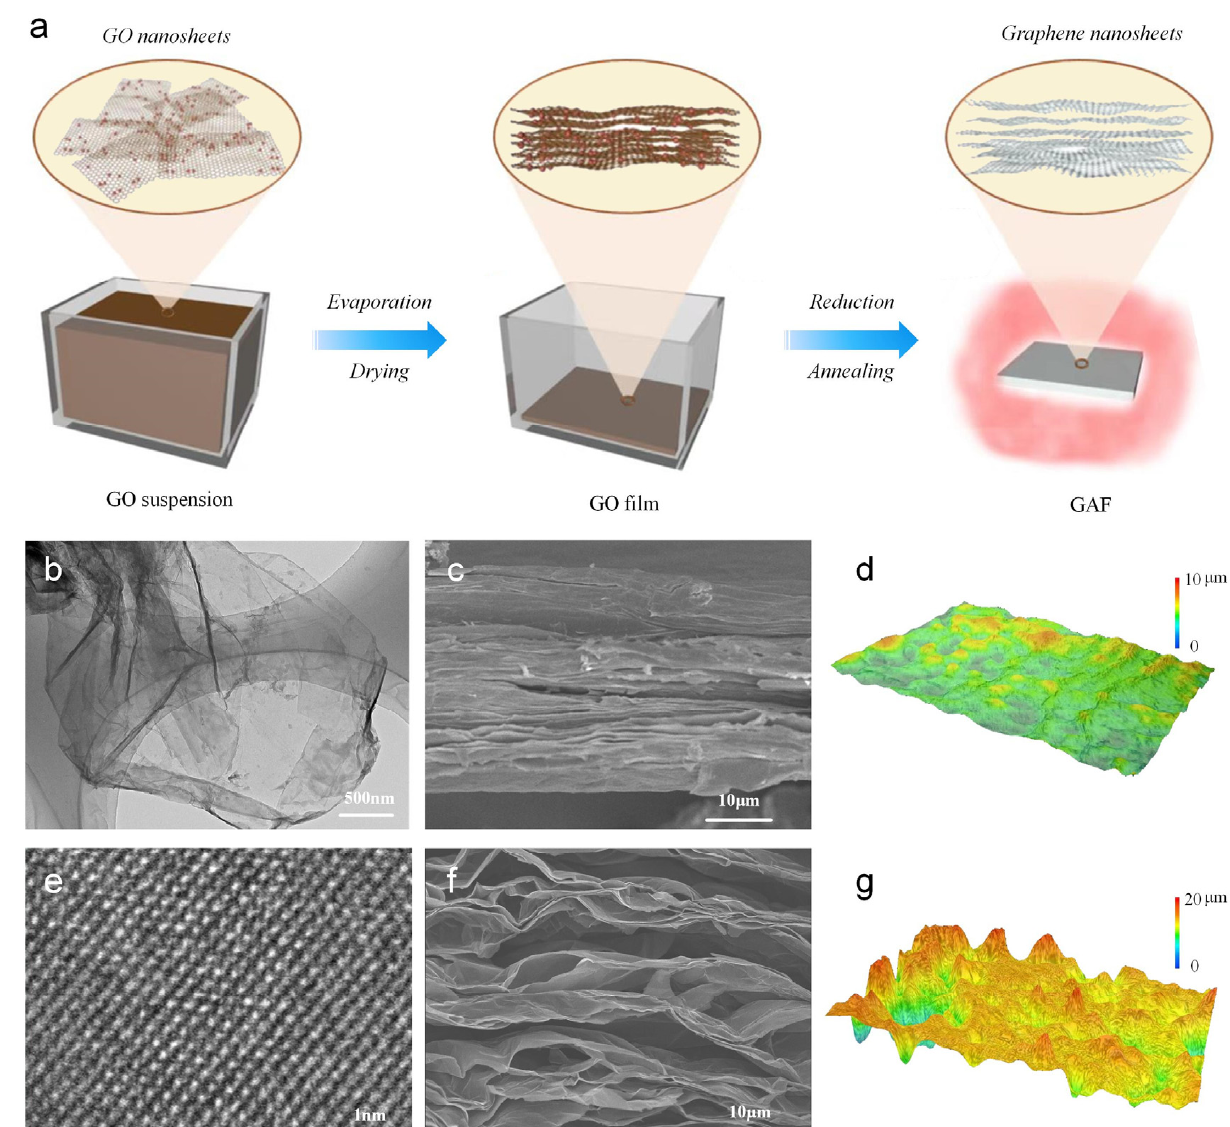
Figure 1. Reduction of the GO nanosheets. ( a ) Schematic illustration of the reduction process. ( b ) HRTEM image of GO nanosheets. ( c ) Cross-sectional SEM image of GO film. ( d ) The surface picture of the GAF taken by a super-large depth of field 3D microscopic system for GO film. ( e ) HRTEM image of rGO ( f ) SEM image of the obtained GAF. ( g ) The surface picture of the GAF taken by a super-large depth of field 3D microscopic system for GAF.